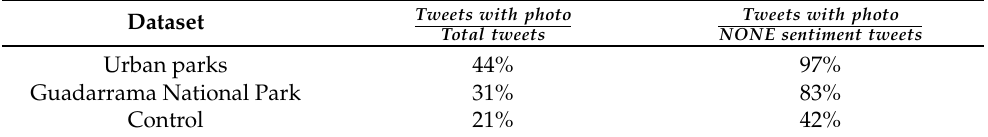
Table 4. Comparison of the number of images in the datasets.